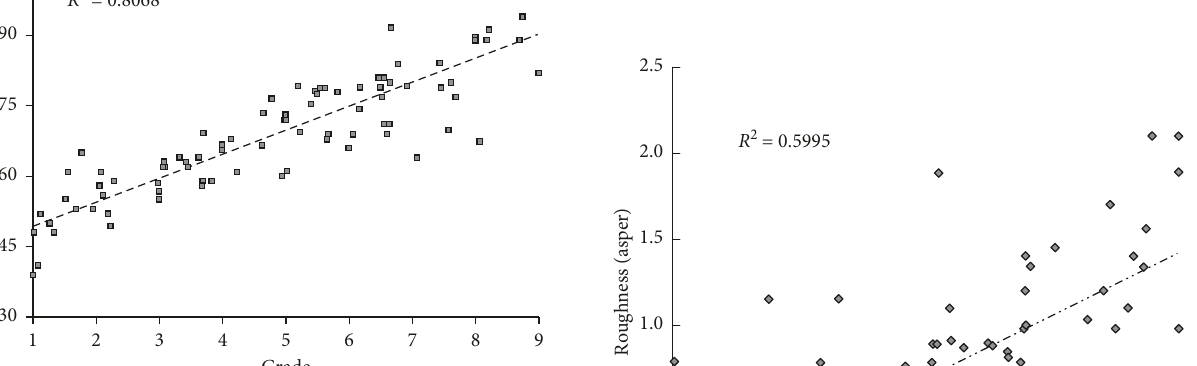
Figure 8: Correlation between sharpness and evaluation score.